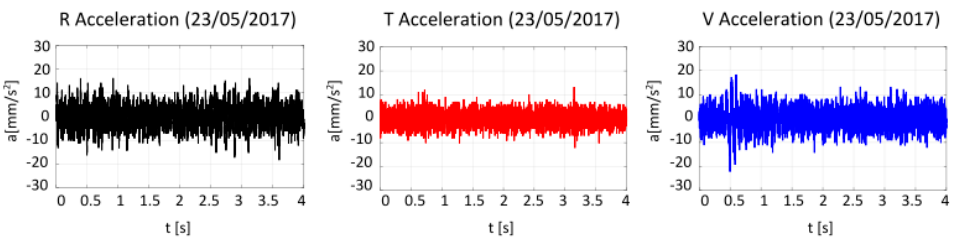
Figure 8. Radial ( R ), Transversal ( T ) and Vertical ( V ) average acceleration time histories derived from the velocity time histories shown in Figure 7.